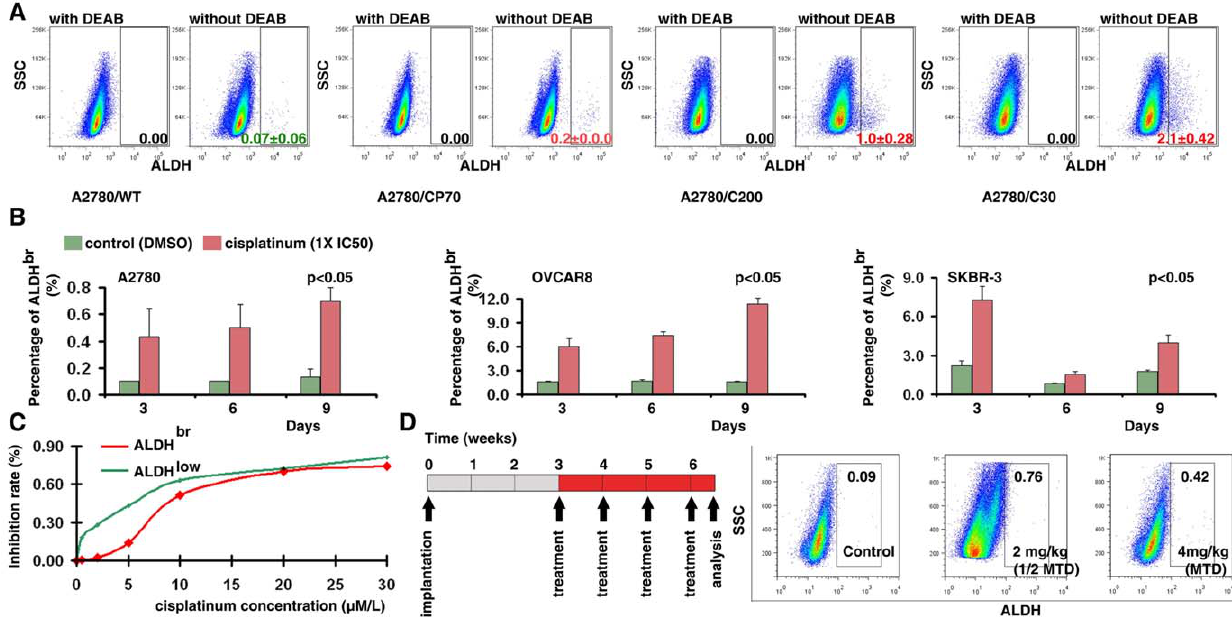
Figure 6. ALDH br tumor cells are resistant to the chemotherapeutic drug platinum. A . ALDH br cells were remarkably expanded in platinum resistant cell lines (A2780/CP70, A2780/C200 and A2780/C30) compared to their parental platinum sensitive line (A2780/WT). B . In vitro platinum treatment significantly increased the ALDH br cell population in ovarian and breast cancer cell lines after three days. C . ALDH br cells were resistant to platinum treatment. ALDH br and ALDH low cells were isolated by FACS sorting. D . ALDH br tumor cell population was resistant to chemotherapy in vivo . The q7d 6 4 i.p. treatment schedule was used for the experimental therapy. Tumors were collected and disassociated by enzyme digestion. Percentage of the ALDH br population was analyzed by ALDEFLUOR assay.